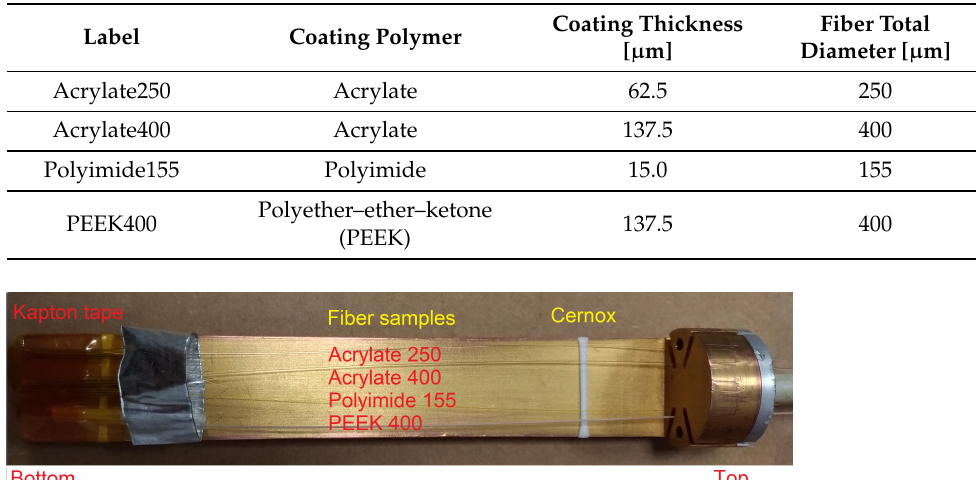
Figure 1. Arrangement of the fiber samples over the cryocooler platform. The fibers enter the platform from the holder on the top and were fixed at the bottom with caption tape. The fiber samples were, from the top as follows: Acrylate250, Acrylate400, Polyimide155,